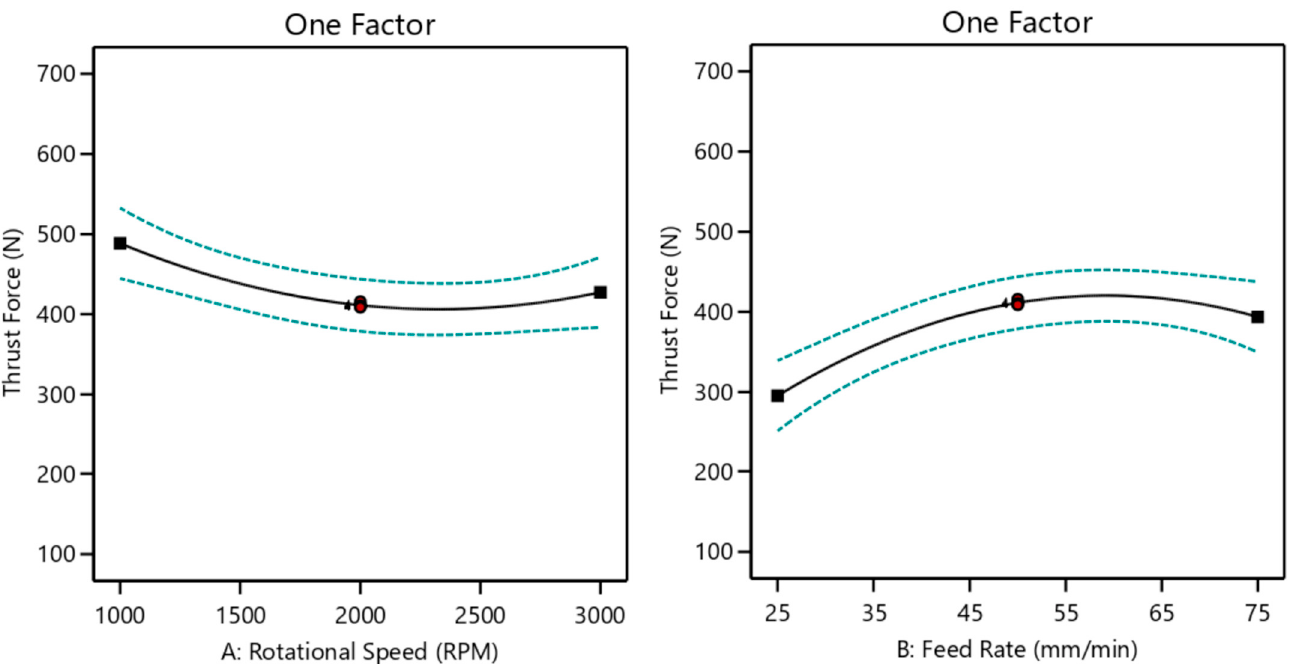
Figure 8. Effect of rotational speed and feed rate on thrust force.